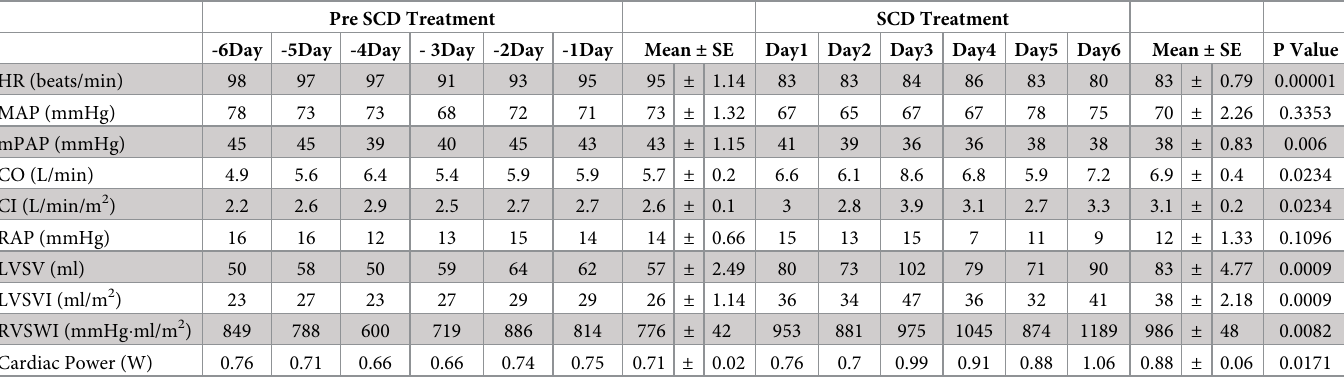
Table 3. Cardiac parameters of enrolled subject. Pre SCD Treatment SCD Treatment